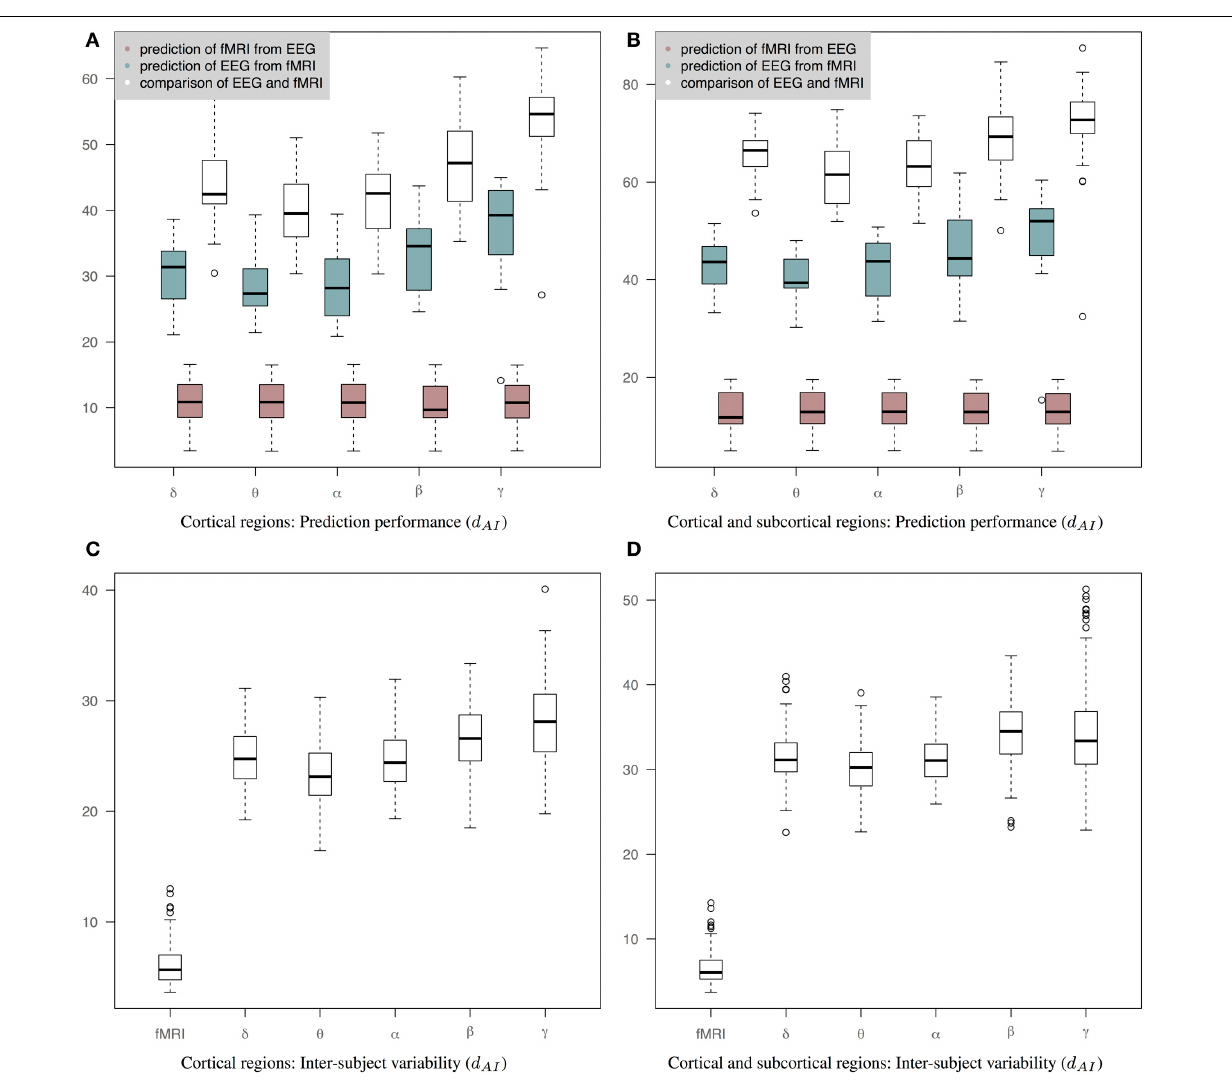
matrices and the EEG precision matrices within subjects (white box-plots), (B) It shows results based on both cortical and sub-cortical regions that summarize the prediction performance of fMRI from EEG (brown box-plots) and EEG from fMRI (green box-plots) across bands, as well as the distance between the fMRI precision matrices and the EEG precision matrices within subjects (white box-plots), (C) It shows inter-subject variability for the precision matrices estimated within cortical regions. (D) It shows inter-subject variability for the precision matrices estimated within cortical and subcortical